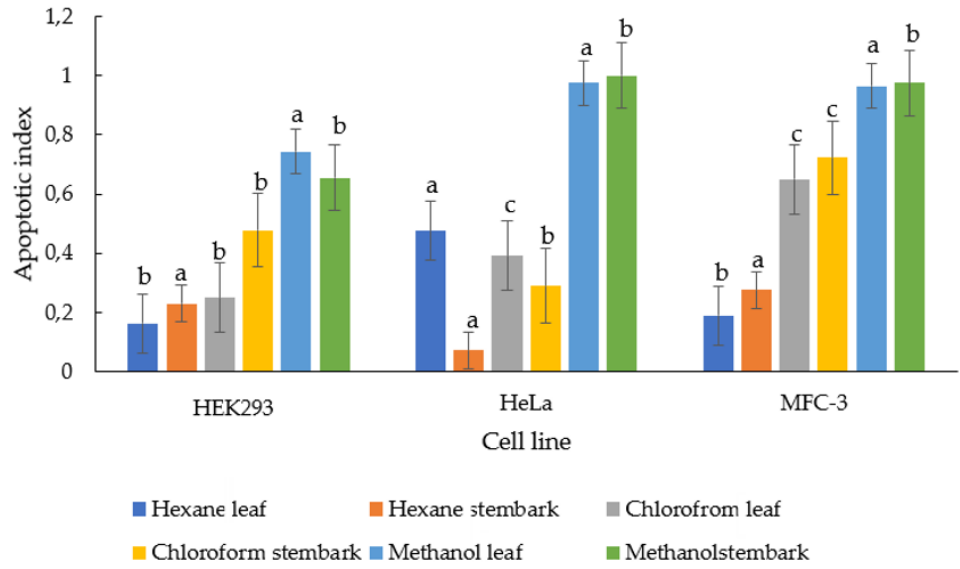
Figure 7. Apoptotic index of three cell lines against C. erythrophyllum leaf and stembark extracts (240 µg/mL) extracted in three different solvents. Mean values ± SD, n = 3. a–c letters above the bars indicate significantly different data (Tukey’s honest significant difference multiple range post hoc test, p < 0.05).